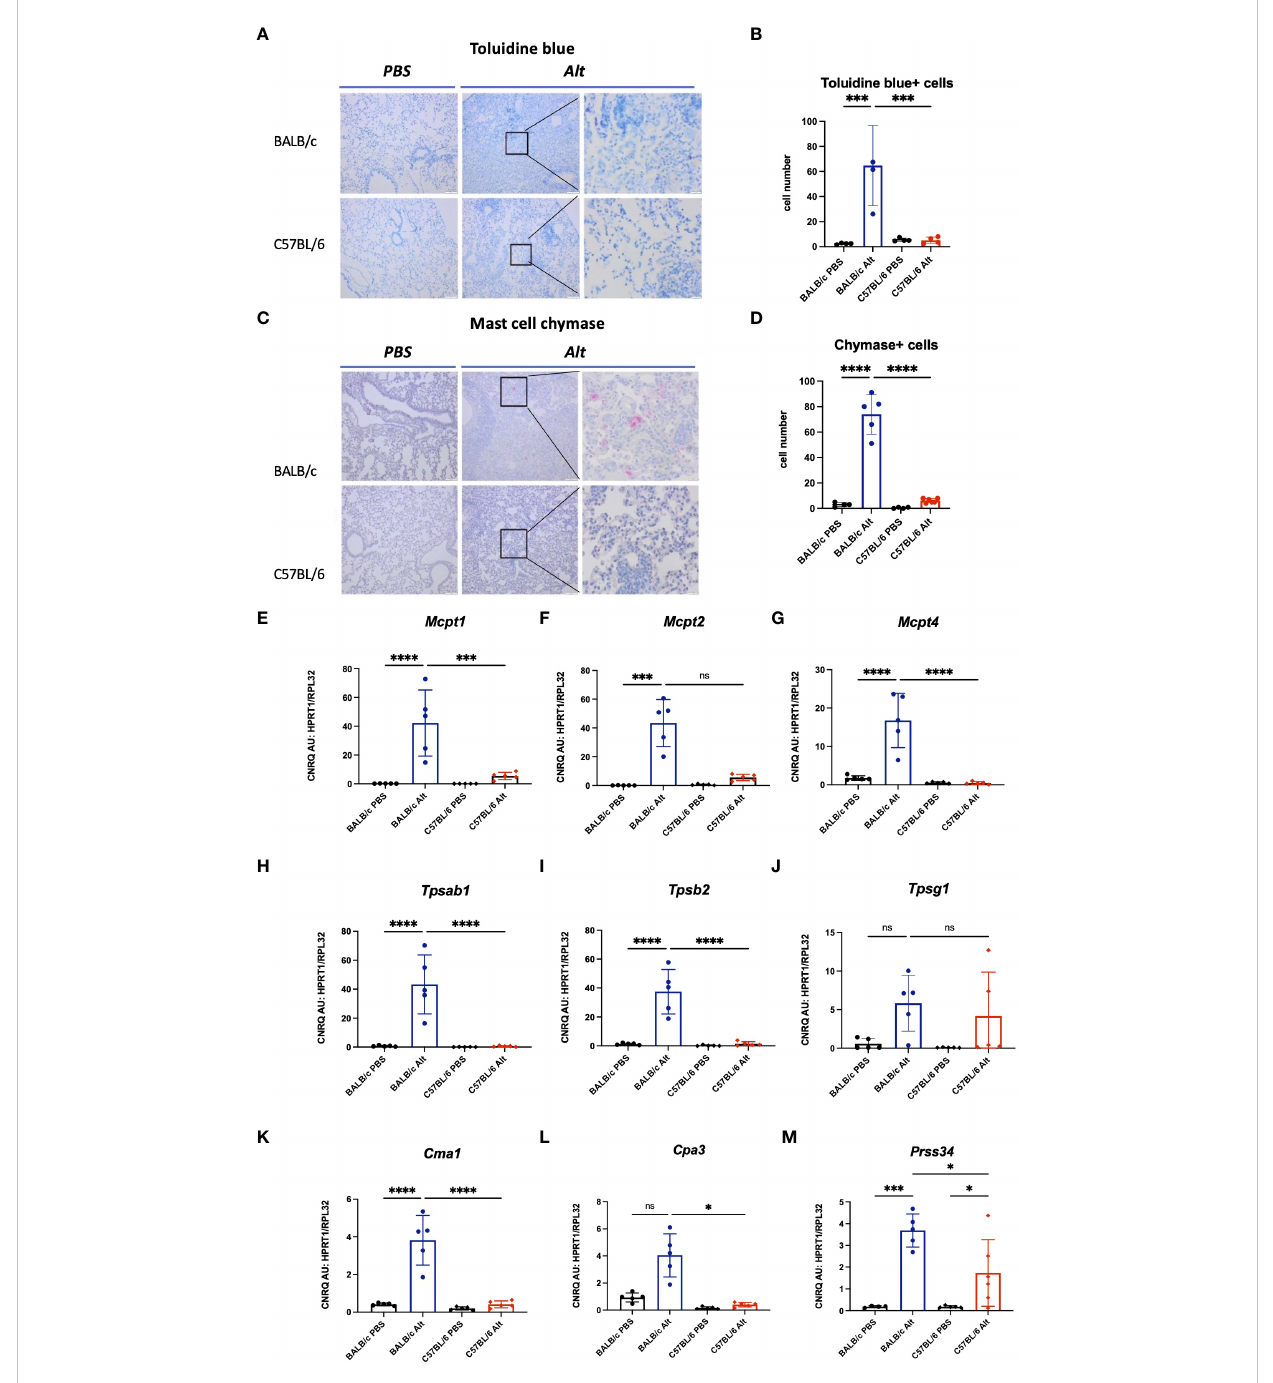
FIGURE 3 To visualize mast cells, formalin- fi xed paraf fi n-embedded lung sections were stained with toluidine blue (A) and the number of mast cells was quanti fi ed in four different fi elds per mouse under magni fi cation of forty times (B) . Chymase - positive mast cells in the lungs of mice were visualized by immunohistochemistry (C) and quanti fi ed (D) . Expression of mast cell proteases in the lungs of BALB/c and C57BL/6 mice treated with six intratracheal applications of 20 µg Alt extract or PBS. Values of gene expression of Mcpt1 (E) , Mcpt 2 (F) , Mcpt4 (G) , Tpsab1 (H) , Tpsab2 (I) , Tpsg1 (J) , Cma1 (K) , Cpa3 (L) and Prss34 (M) were normalised using reference genes Hprt1 and Rpl32 . The data are presented as scatter plot with a bar ± standard deviation (S.D.). Statistical signi fi cance between the groups was determined by one-way ANOVA with Sidak ’ s test for multiple comparisons. n=4-6 per group. *p < 0.05, ***p < 0.001, ****p < 0.0001. ns, not signi fi